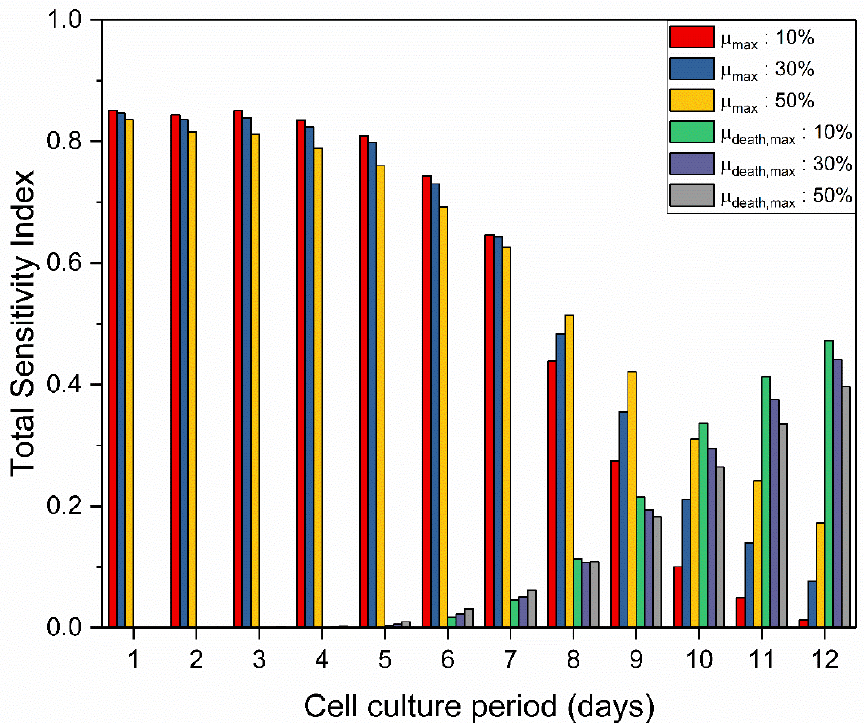
Figure 3. TSI values for different deviation ranges of the values for 𝜇 𝑚𝑎𝑥 and 𝜇 𝑑𝑒𝑎𝑡ℎ,𝑚𝑎𝑥 within the cell culture time period. For all the presented sensitivity analyses Sobol’ method was used as the sampling method and viable cell density as the examined output.